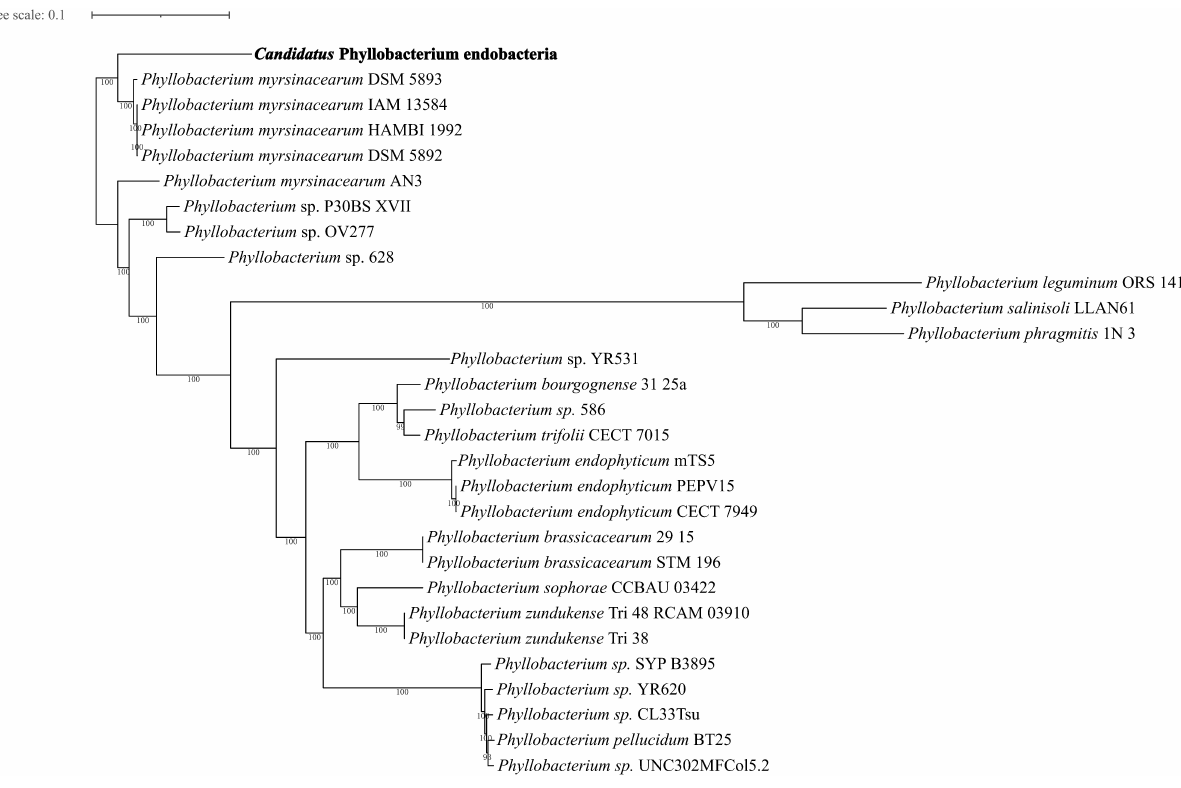
FIGURE 2 | The maximum likelihood tree based on concatenated 879 amino acid sequences from single copy genes of endobacteria and close relatives within the genus Phyllobacterium was inferred using the automated protein model assignment algorithm and a gamma model of rate heterogeneity (-m PROTGAMMAAUTO). 100 bootstrap replicates were used to produce the phylogenetic tree using amino acids sequence. Bootstrap values were given at each